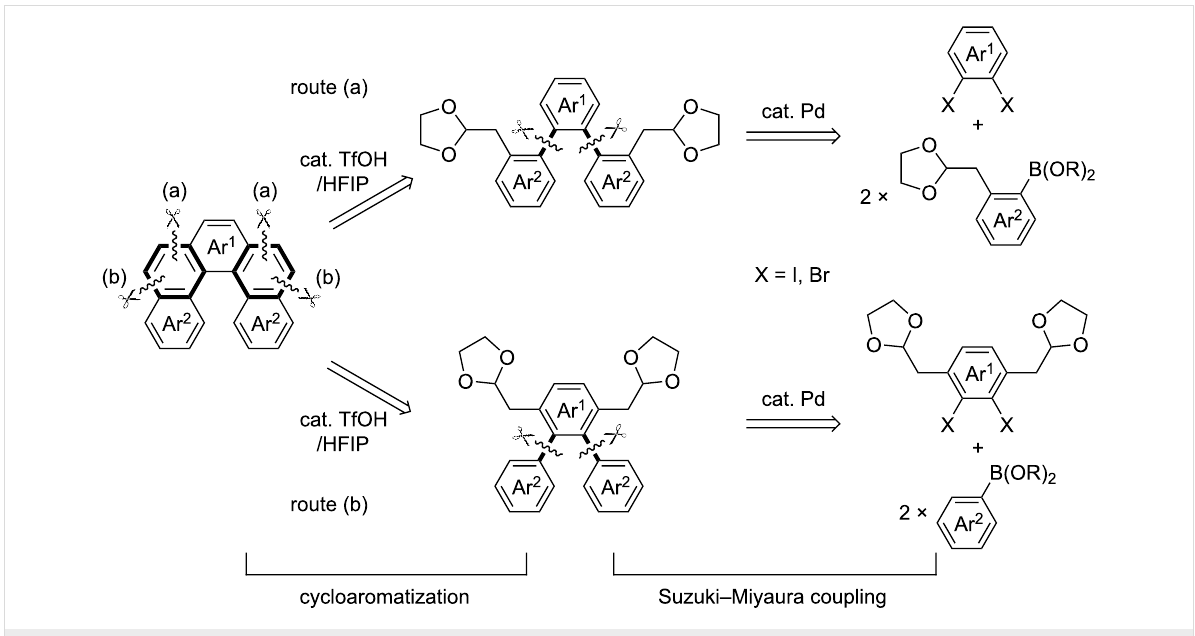
Scheme 3: Two strategies for the helicene synthesis via Suzuki–Miyaura coupling/cycloaromatization